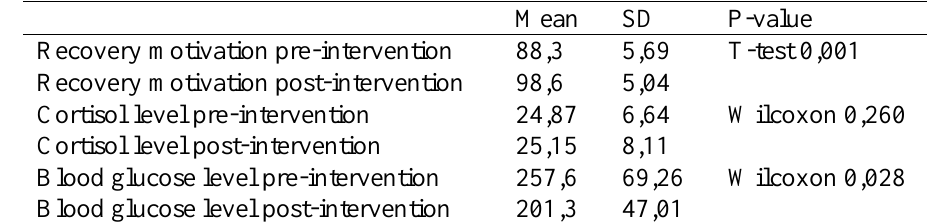
Table 2. Analyze result deferent test (pre-post) recovery motivation, cortisol and blood glucose level in control group